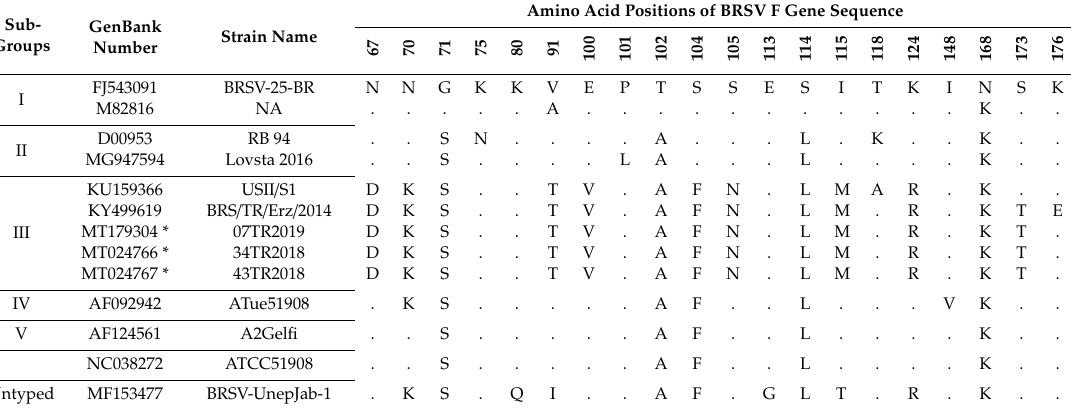
Table 3. Partial alignment of the F gene from the isolates identified in this study (marked with *), with a selection of strains from the di ff erent subgroups. NA: Not